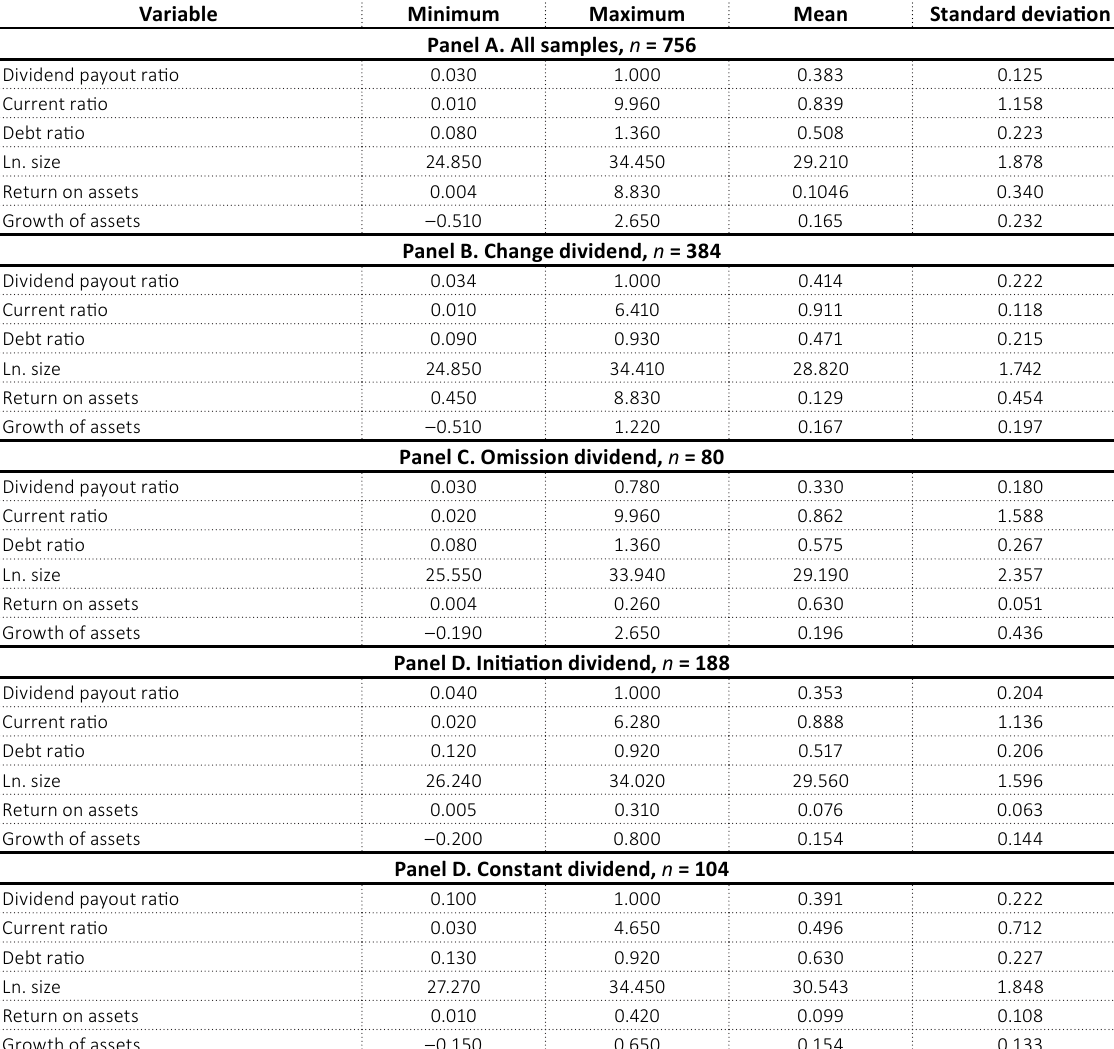
Table 4. Descriptive statistic of research